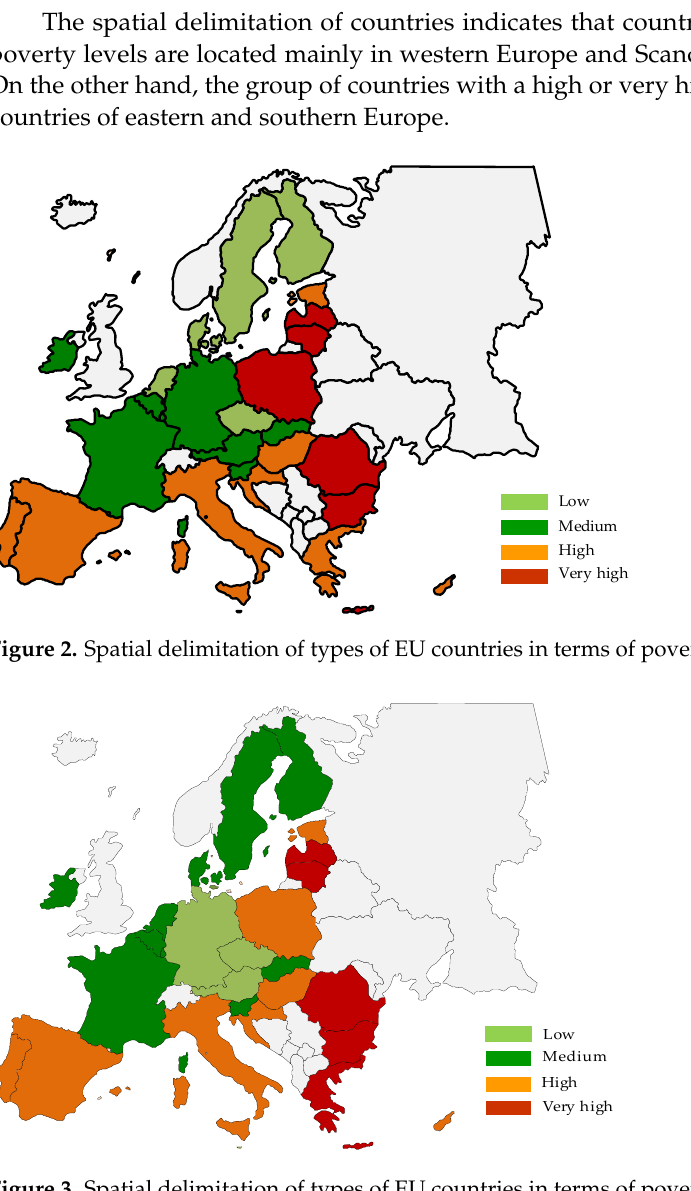
Figure 3. Spatial delimitation of types of EU countries in terms of poverty level in 2019.